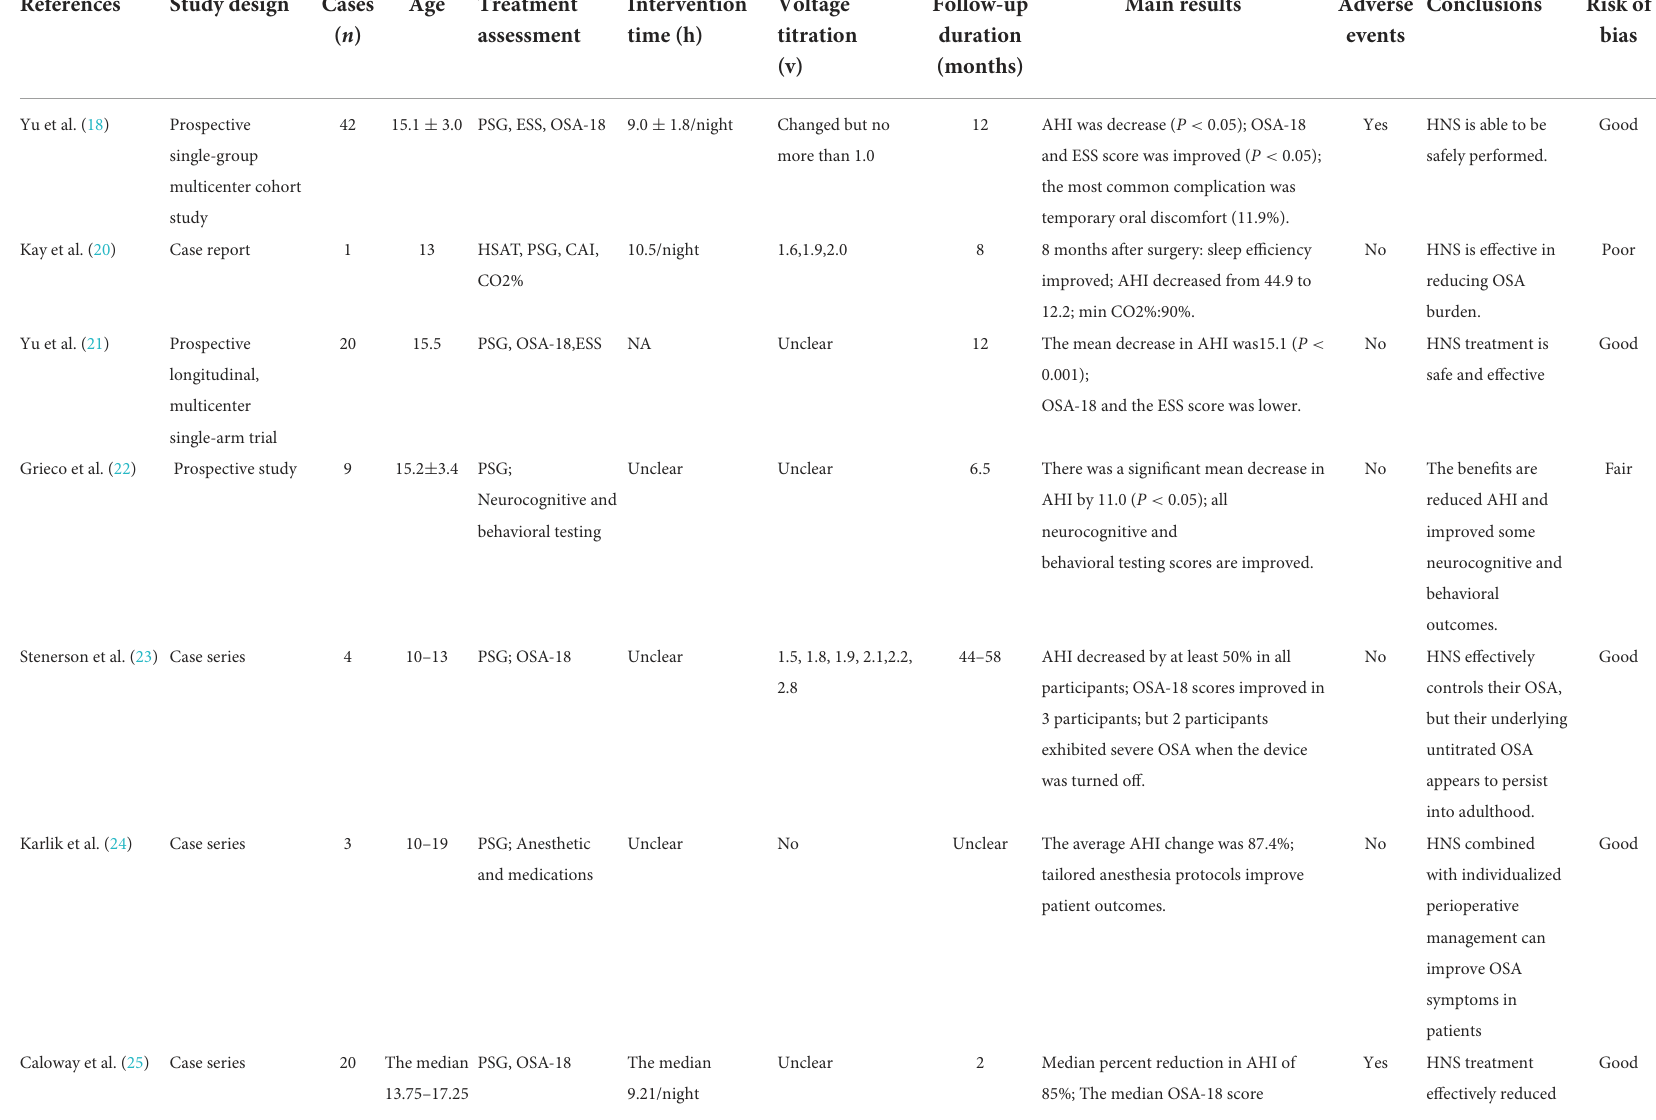
TABLE 1 A summary of studies on hypoglossal nerve stimulation for adolescents who had down syndrome and